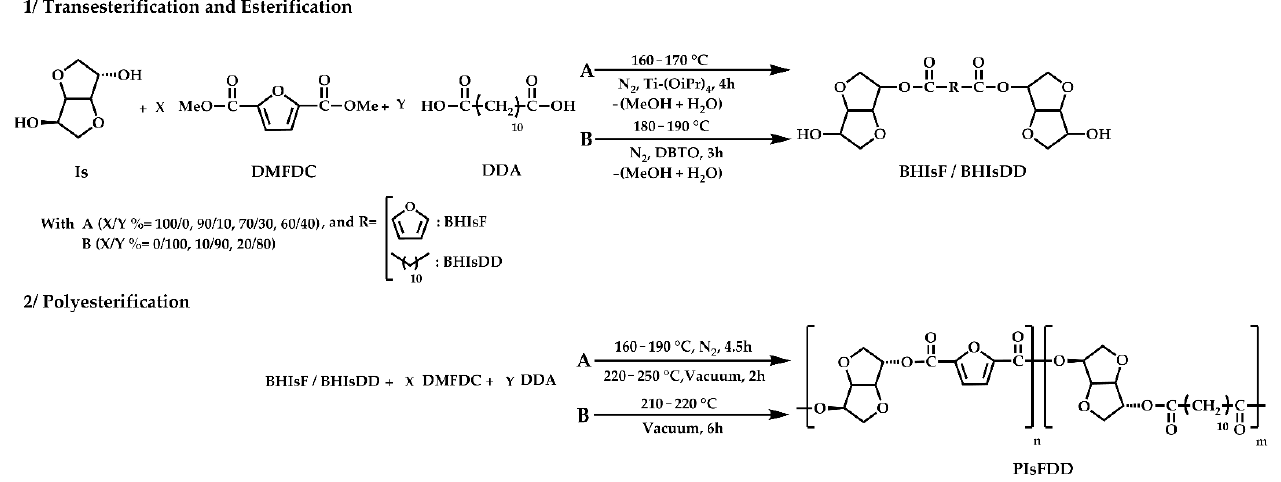
Scheme 1. Synthesis of poly(isosorbide 2,5-furandicarboxylate)- co -(isosorbide 1,12-dodecanedioate) copolyesters. Table 1. Feed (F/DD feed ) and real (F/DD real ) molar ratios of furan and 1,12–dodecanedioate moieties.